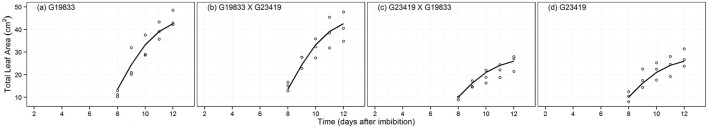
Fitted Gompertz growth curve fitting for total leaf area (LAREA, cm2) of parental genotype (A) G19833, the reciprocal F1 hybrids (B) (G19833 × G23419), (C) (G23419 × G19833), and parental genotype (D) G23419.